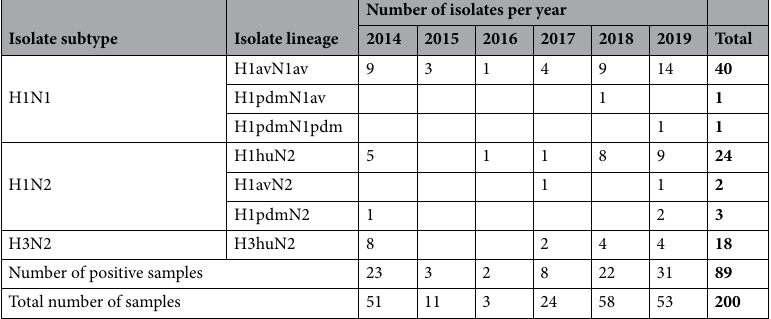
Table 2. Subtypes of swIAV isolated from pigs in Belgium and the Netherlands in the period 2014–2019. The three subtypes of swIAV that circulate in swine are shown in first column. Within each subtype, the lineages/ origin (second column) of the HA and NA are indicated: av—European avian-like; hu—European human-like; pdm—2009